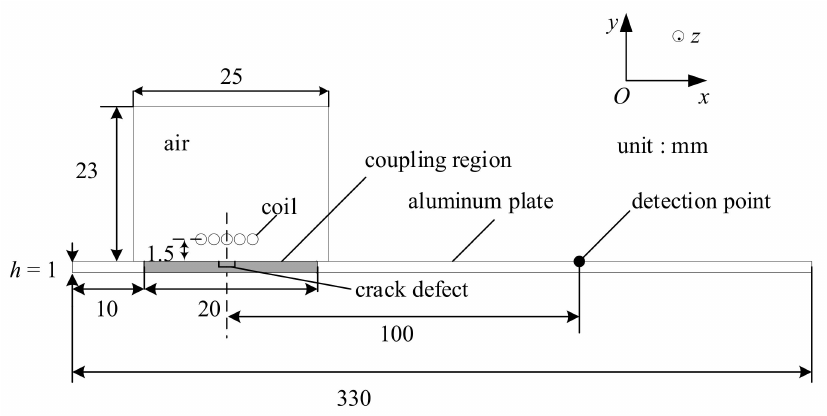
Figure 4. The geometry of the 2-D FE model used to simulate the near-field